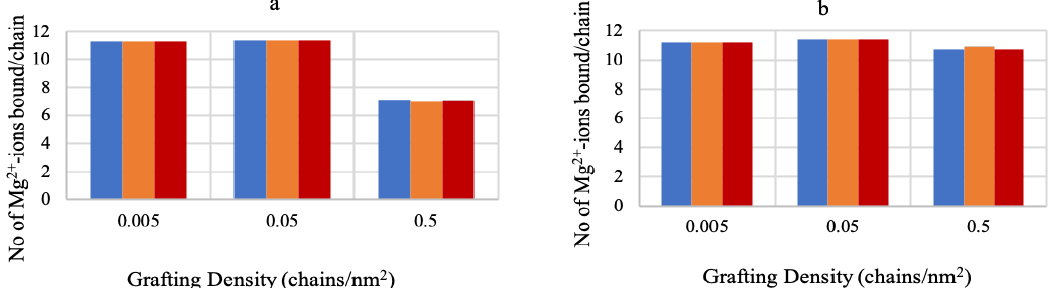
Figure 2. No. of bound Mg 2 + to different ssDNA sequences at varying grafting densities for ( a ) 3 mM MgCl 2 and ( b ) 180 mM MgCl 2 . The color bars correspond to the A-grafted chain (blue), G-grafted chain (yellow), and A-G alternate chain